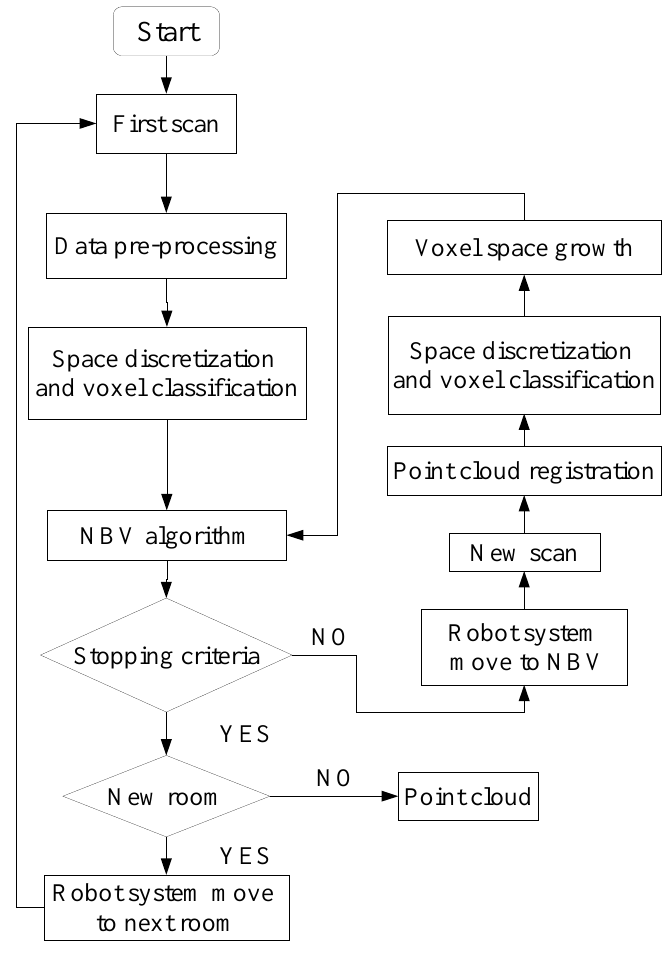
Figure 1 . General workflow of the method. Figure 1. General workflow of the